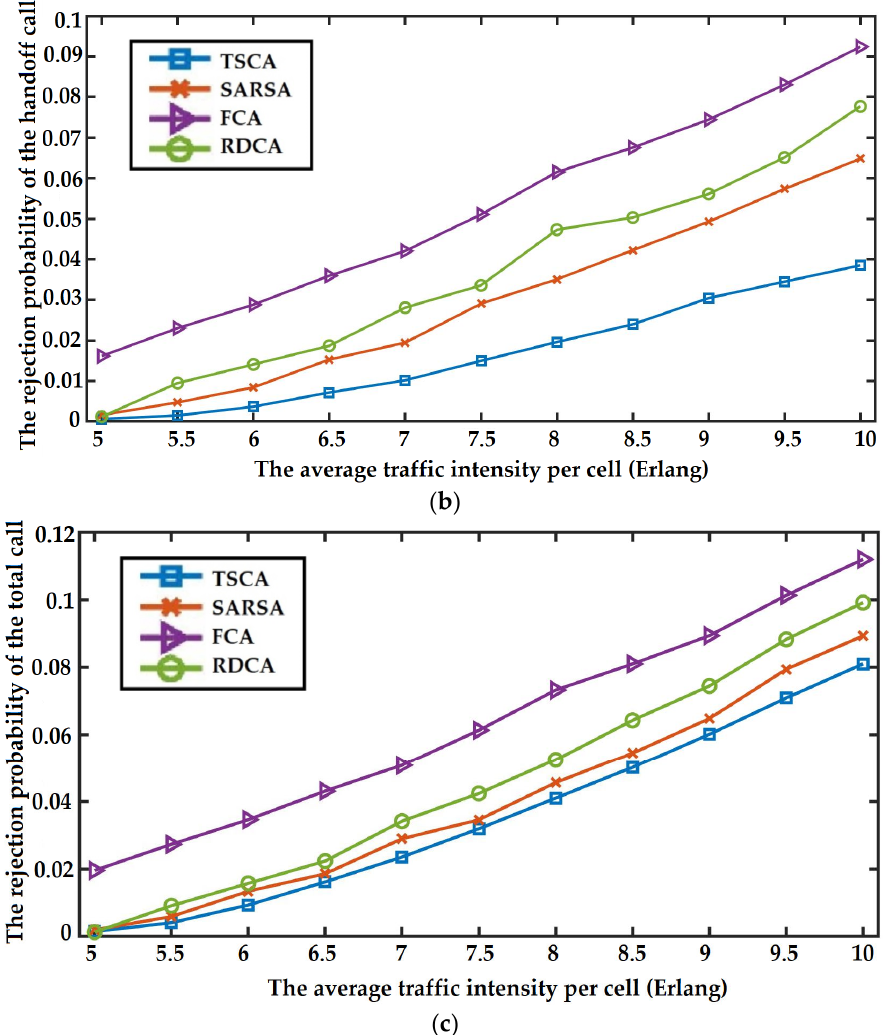
Figure 5. Performance comparison under nonuniform traffic distribution. ( a ) The rejection probability of the new call; ( b ) the rejection probability of the handoff call; ( c ) the rejection probability of the total call.